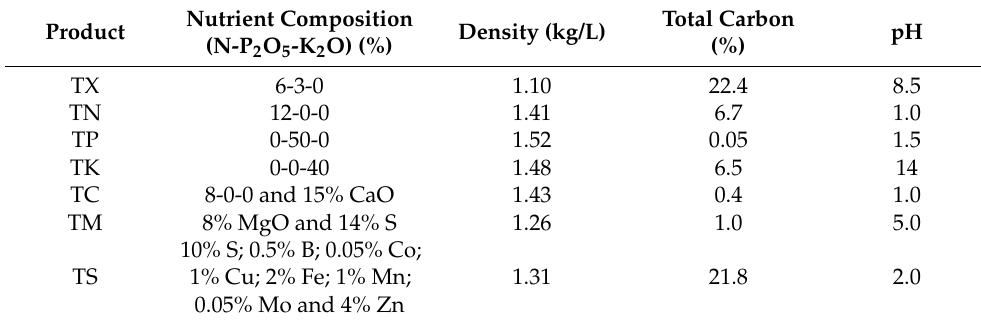
Table 2. Basic properties and nutritional composition of MTC ®